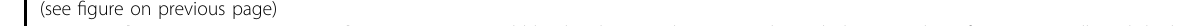
Fig. 3 Uridine treatment promotes hMSC activity. a Bubble plot showing the increased metabolites in at least four tissues/cells with higher regenerative capacity. The bubble sizes are positively correlated to the log 2 (fold change) values. b Top-left, schematic illustration of the screening strategy for candidate metabolites reinforcing self-renewal activity of WS hMSCs. Top-right, scatter plot showing the relative cell proliferative abilities upon treatment with candidate metabolites at indicated concentrations in WS hMSCs. Bottom, top-ranked metabolites at indicated concentrations for cell proliferation are shown in the table. c Schematic representation (left) and quantitative data (right) of the detection of uridine concentration in the plasma of young (19 – 25 years old, n = 28) and aged (75 – 92 years old, n = 21) individuals. d Immunostaining of Ki67 in vehicle- and uridine (200 μ M)-treated WS hMSCs (passage 5, P5) at P2 post treatment. Data are presented as the mean ± SEM (two-tailed unpaired Student ’ s t test). n = 3 biological replicates. Scale bars, 25 μ m. e Cell cycle analysis of vehicle- and uridine (200 μ M)-treated WS hMSCs (P5) at P2 post treatment. Data are presented as the mean ± SEM (two-tailed unpaired Student ’ s t test). n = 3 biological replicates. f SA- β -gal staining of vehicle- and uridine (200 μ M)- treated WS hMSCs (P5) at P2 post treatment. Scale bars, 100 μ m. Data are presented as the mean ± SEM (two-tailed unpaired Student ’ s t test). n = 3 biological replicates. g Toluidine blue staining analysis to evaluate the chondrogenesis of vehicle- and uridine (200 μ M)-treated WS hMSCs (P5) at P2 post treatment. Data are presented as the mean ± SEM (two-tailed unpaired Student ’ s t test). n = 8 biological replicates. Scale bars, 100 μ m. h Heatmap diagrams showing enriched GO terms and pathways for upregulated genes (left) and downregulated genes (right) in uridine (200 μ M)- treated WS hMSCs (P5) at P2 post treatment as compared to vehicle-treated counterparts. The color keys from white to red or blue indicate the enrichment levels [ – log 10 ( P -value)] from low to high. i Gene set enrichment analysis (GSEA) showing representative GO terms and pathways in uridine (200 μ M)-treated WS hMSCs (P5) at P2 post treatment as compared to vehicle-treated